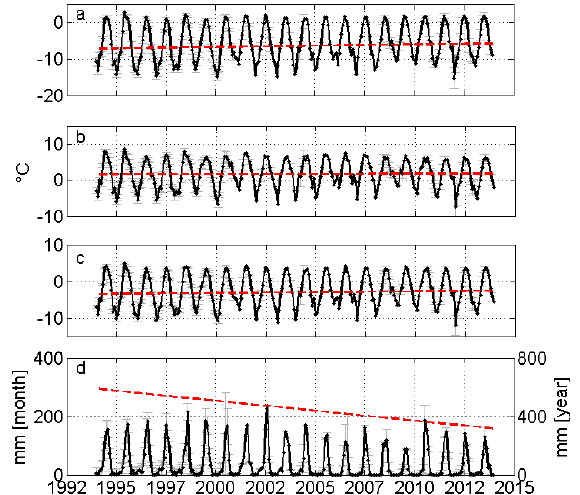
Figure 3. Temperature and precipitation monthly time series (1994– 2013) reconstructed at high elevations of Mt. Everest (PYRAMID): minimum (a) , maximum (b) , and mean temperature (c) , and precip- itation (d) . Uncertainty at 95% is presented as a grey bar. The red lines represents the robust linear fitting of the time series character- ized by the associated Sen’s slope. According to Dytham (2011), the intercepts are calculated by taking the slopes back from every obser- vation to the origin. The intercepts used in here represent the median values of the intercepts calculated for every point (Lavagnini et al., 2011). For precipitation the linear fitting refers to the right